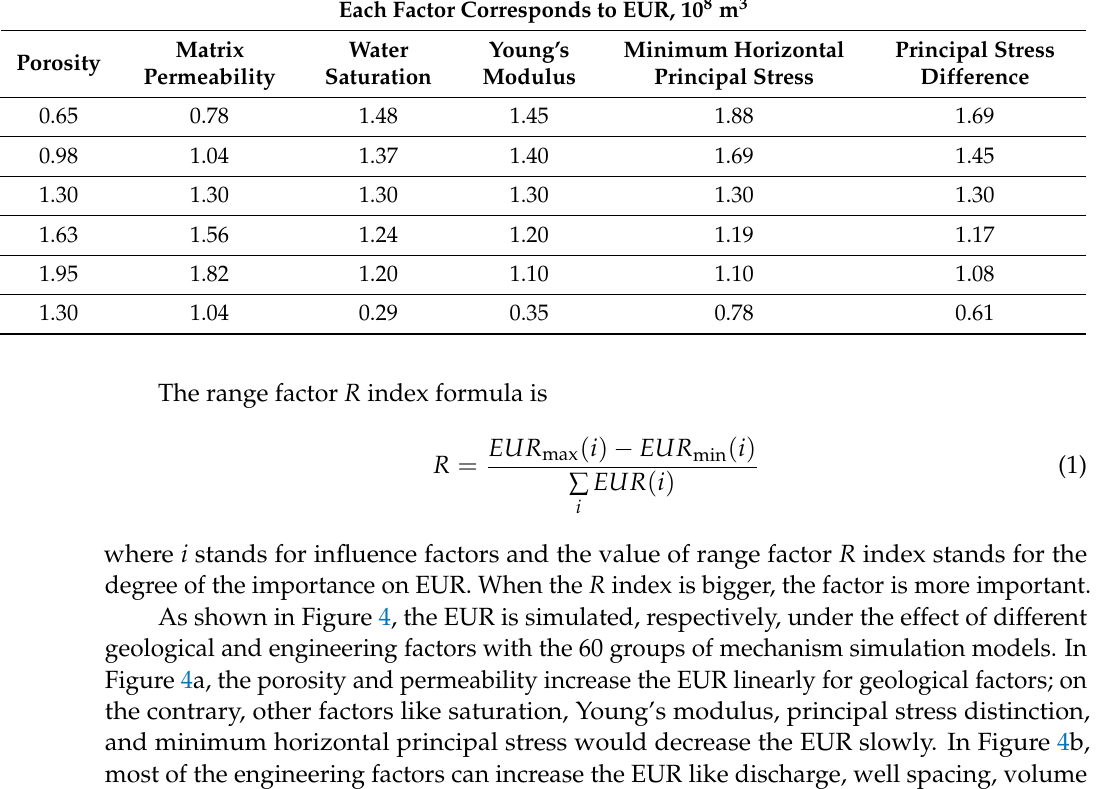
Table 3. Influence of geological parameters on